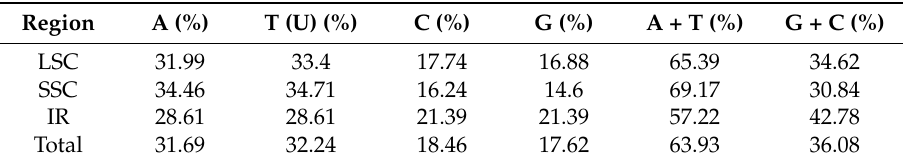
Table 2. Base composition of the Q. acutissima chloroplast genome.